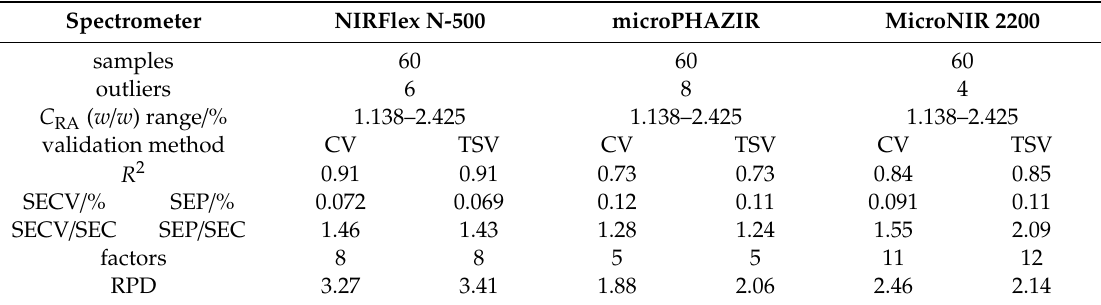
Figure 8. PLS regression coe ffi cients plots for the best performing calibration models for verbenalin and verbascoside content in Verbena o ffi cinalis samples. The models were constructed for NIR spectra measured on NIRFlex N-500 (benchtop) and microPhazir (miniaturized) spectrometers. Reproduced with permission from Elsevier, Ref. [77]. Table 5. Performance parameters of PLS regression models for the prediction of rosmarinic acid content C RA in Rosmarinus o ffi cinalis , folium. Reproduced with permission from Royal Society of Chemistry, Ref.